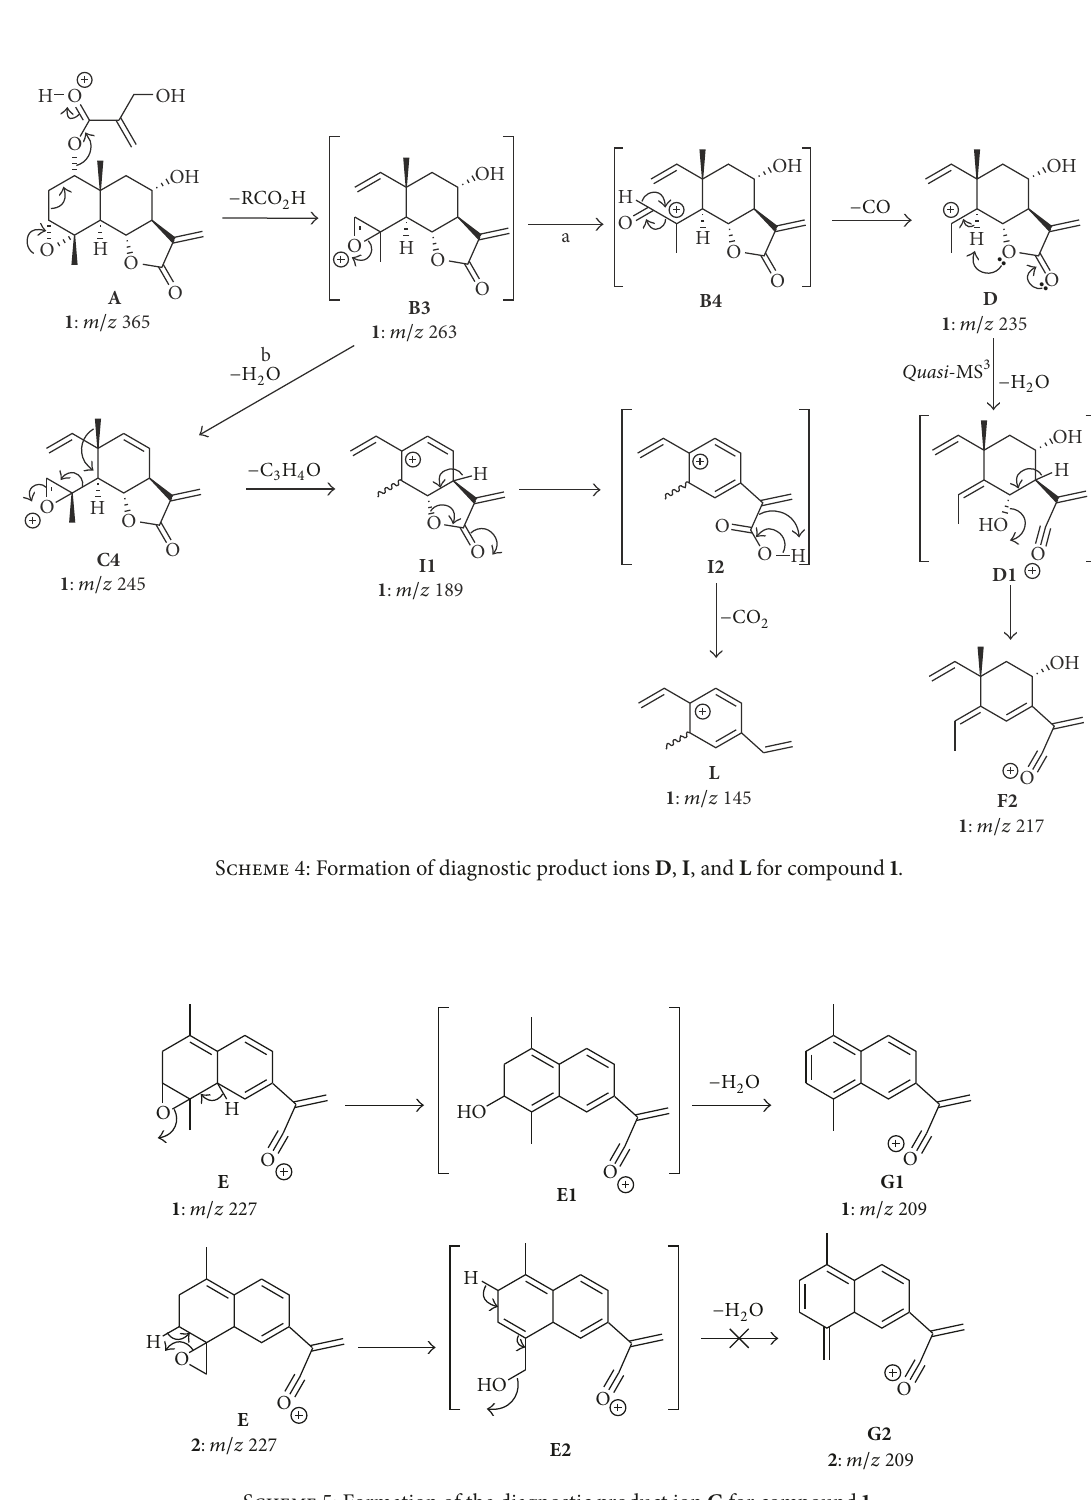
Scheme 5: Formation of the diagnostic product ion G for compound 1